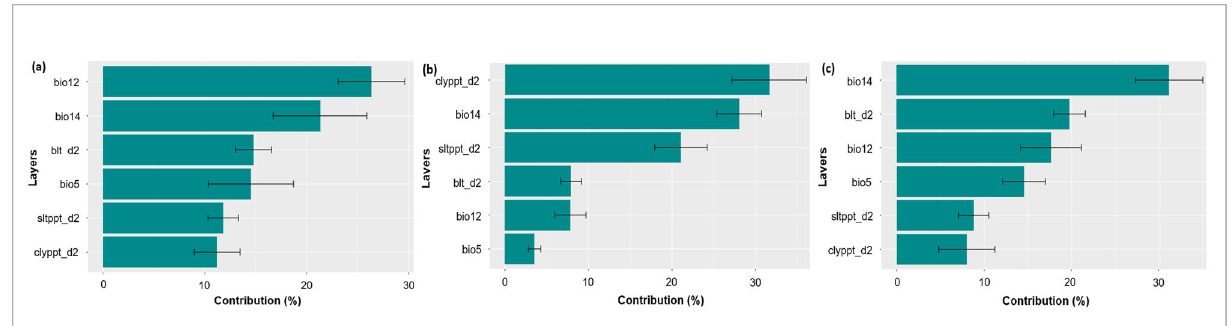
Figure 7. Environmental contribution for the species ( a ) and genetic Pop1 ( b ) and Pop2 ( c ). bio5 max temperature warmest month, bio12 mean annual rainfall, bio14 rainfall driest month, blt_d2 bulk density in kg/